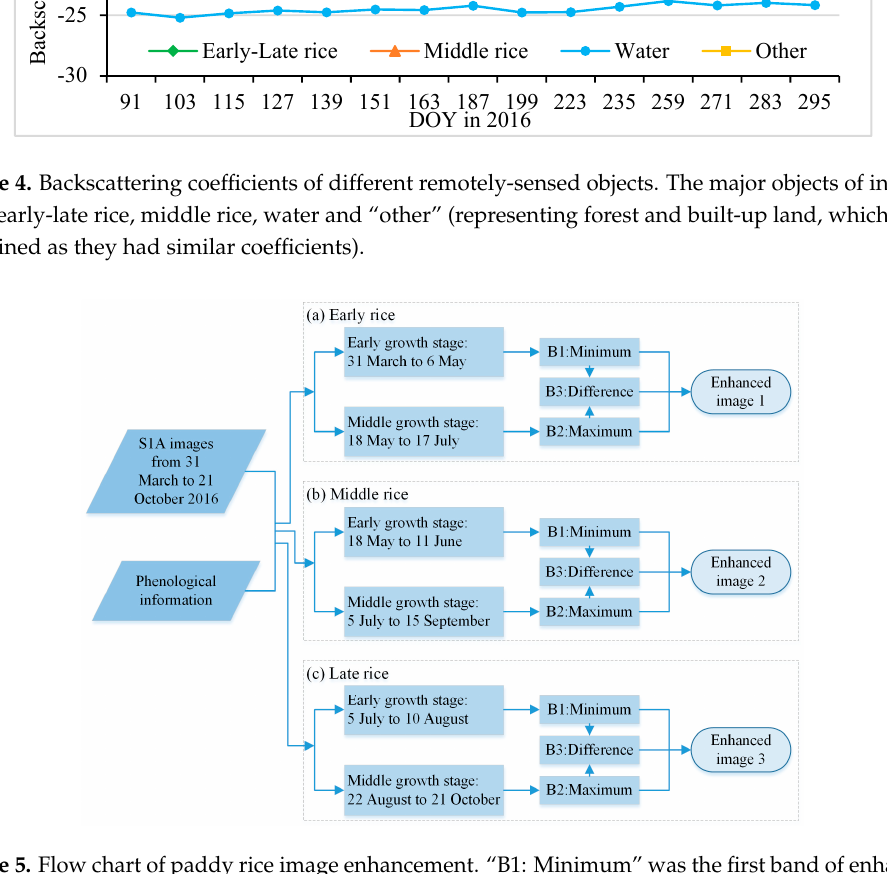
Figure 6. “Enhanced image 1”, where purple is the extent of early rice cultivation, black is water, and yellow is forest and built-up land. Enhanced image 1 is a false color image, where red is the second band (maximum backscattering coefficient band), green is the first band (minimum backscattering coefficient band), and blue is the third band (difference between bands 1 and 2). Enhanced images 2 and 3 are not given here, but are similar to this one.